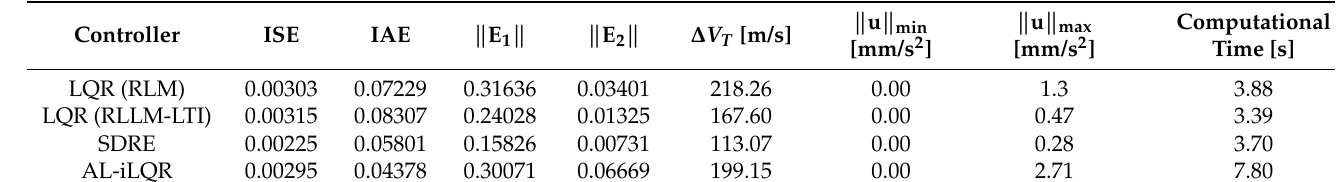
Table 5. Performance comparison for the continuous guidance schemes.